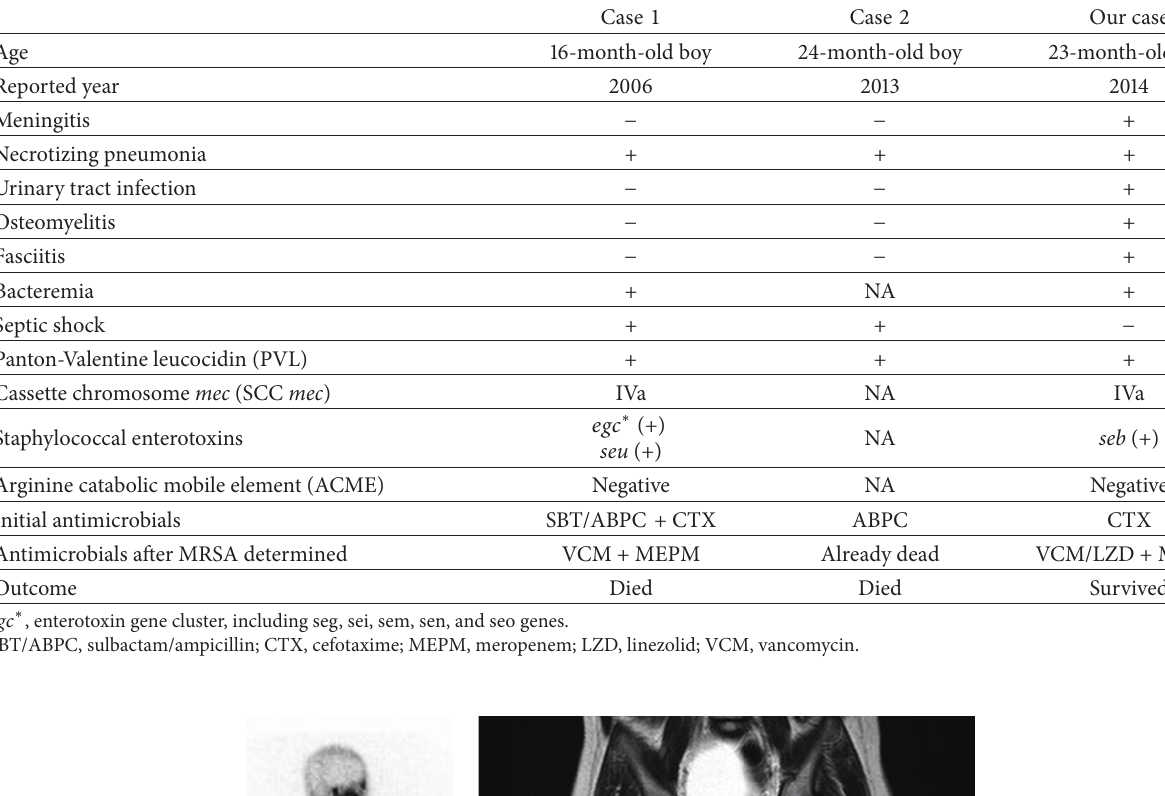
Table 1: The review of Japanese pediatric cases with severe CA-MRSA infection.